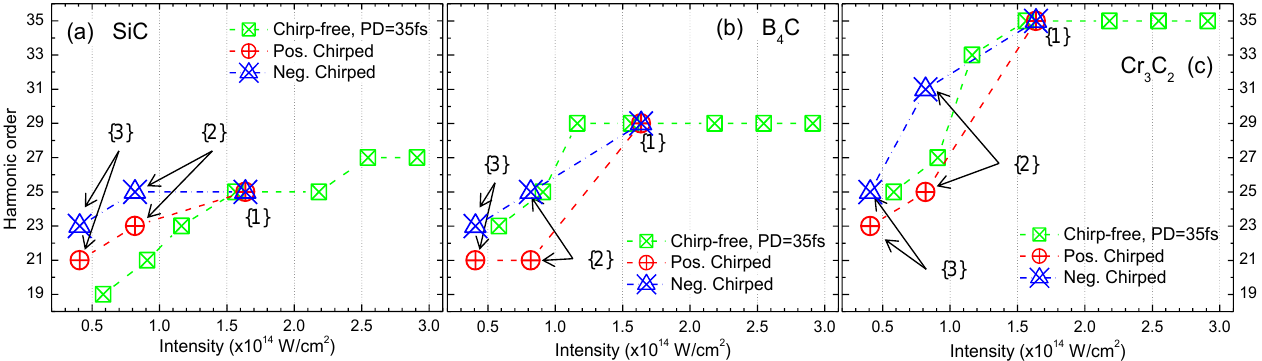
Figure 5. Cutoff position dependencies for ( a ) SiC, ( b ) B 4 C, and ( c ) Cr 3 C 2 NP plasmas at different I PP intensities for chirp-free 35 fs pulses (crossed green squares), positively chirped pulses (crossed red circles), and negatively chirped pulses (crossed blue triangles). Point {2} and {3} designate chirped pulses with the same pulse durations, 70 fs and 130 fs correspondingly, but possessing opposite signs of chirp. Point {1} designates share points where red and blue curves achieve chirp-free 35 fs pulse by tuning distance between CG and HRR (see Figure 1).